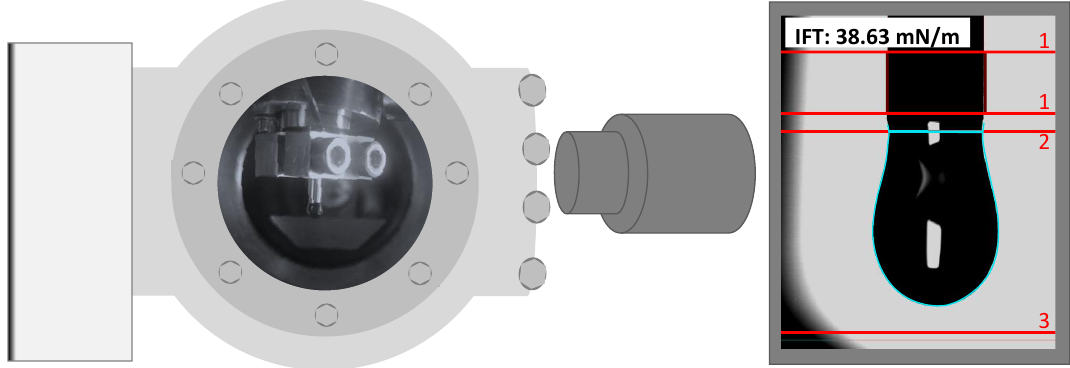
Figure 2. Concept and construction to form a drop in HV: a ) Representation of the inner part in the vacuum consisting of a stamp, reservoir with degassing holes and cannula. The stamp is pushed in the reservoir to press the liquid (in yellow) into the cannula forming a drop at its tip. b ) Full setup with the micrometre screw moving the stamp in a vertical direction.